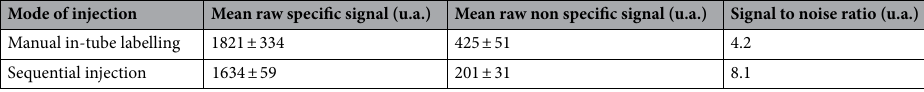
Table 1. Influence of the process of injection on the specific and non-specific signal. The experiments are performed with a sample of IL-6 at 10 ng/mL (for the specific signal) or a buffer solution mL (for the non- specific signal) as described in the Material and Methods.